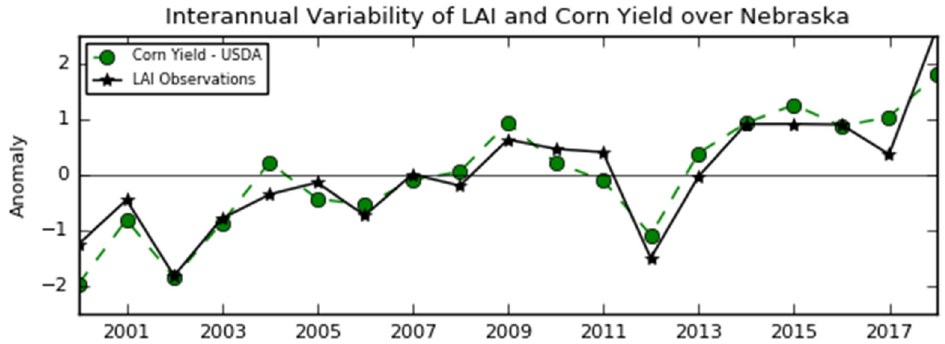
Figure 11. Inter-annual variability of CGLS LAI anomalies compared to USDA recorded corn yield Figure 11. Inter ‐ annual variability of CGLS LAI anomalies compared to USDA recorded corn yield anomalies over the U.S. state of Nebraska. Correlation coe ffi cient of the anomalies is anomalies over the U.S. state of Nebraska. Correlation coefficient of the anomalies is 0.92.